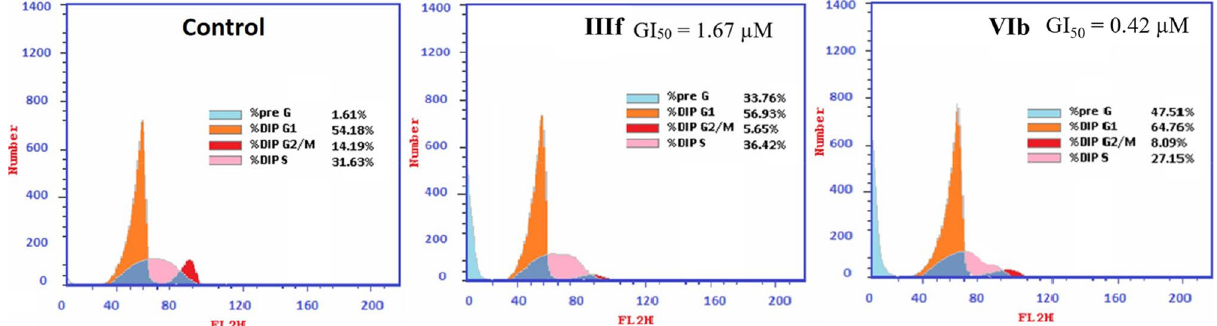
Figure 11. Cell cycle analysis of ( IIIf ) and ( VIb ) on MCF-7 cells following 24 h incubation at their respective GI 50 . Analysis performed using Cell Quest software 5.2.1 (https:// www. bdbio scien ces. com, Becton Dickinson Immunocytometry Systems, San Jose, CA).